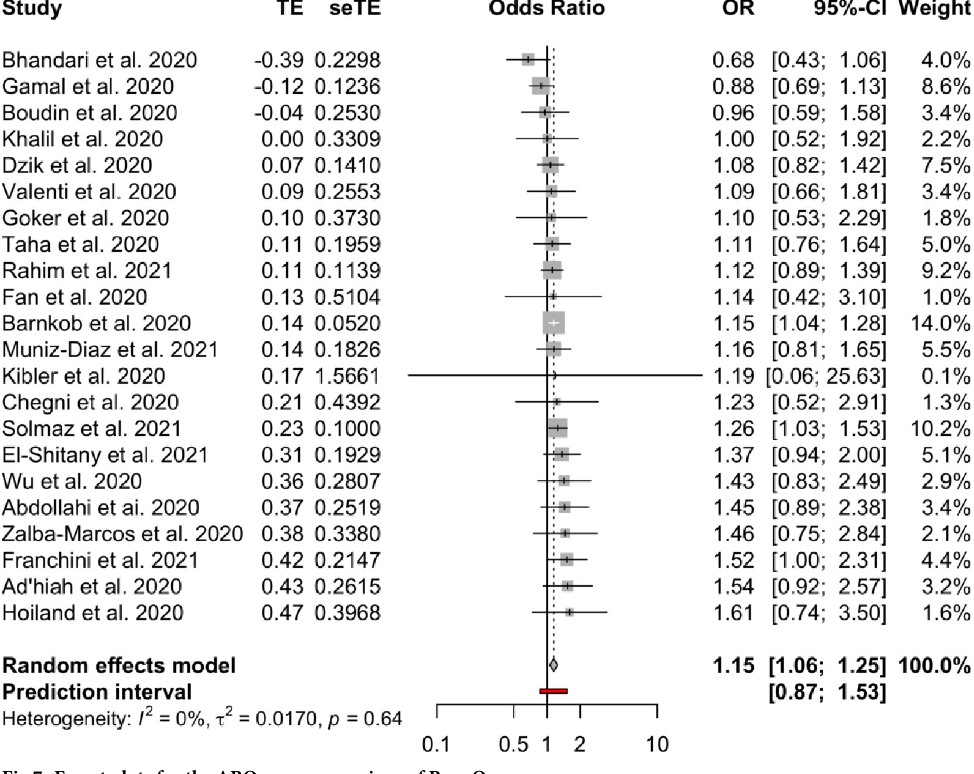
Fig 7. Forest plots for the ABO gene comparison of B vs. O group.